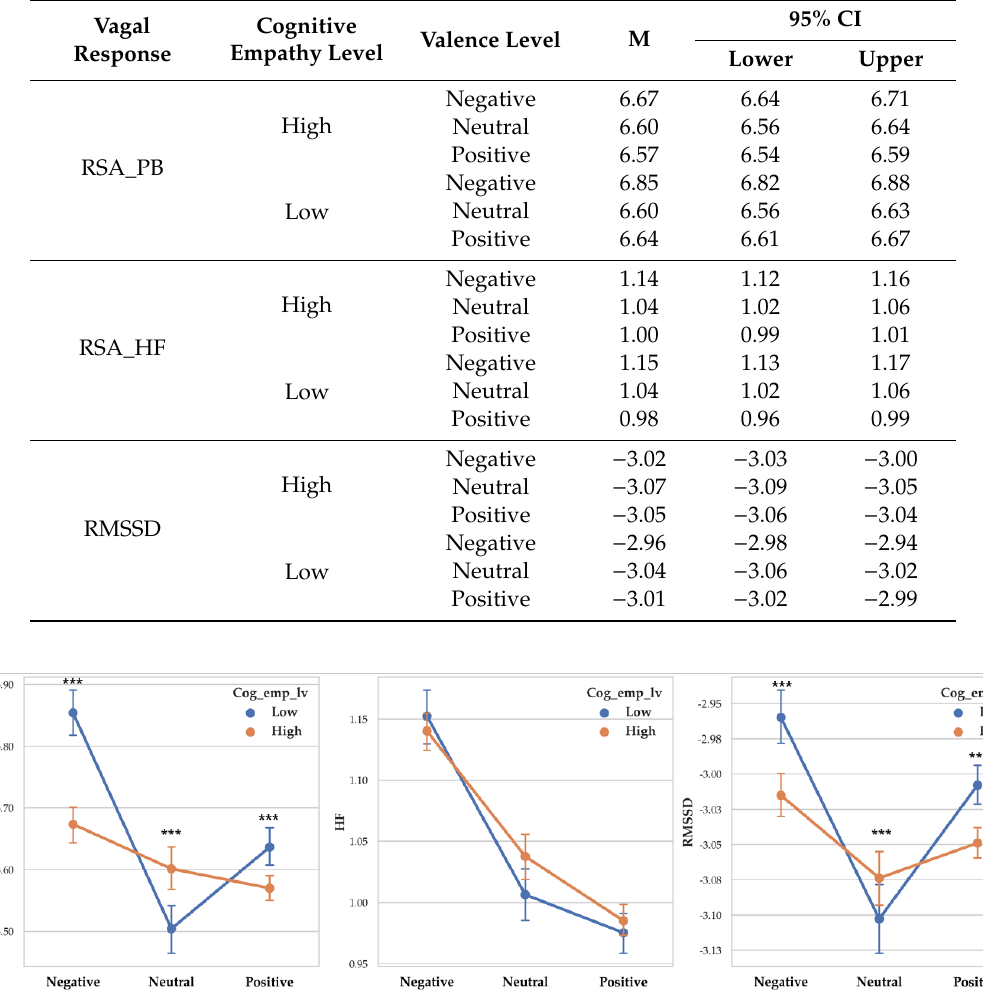
Figure 4. Point graph of vagal responses depending on cognitive empathy level and valence. Cog_emp_lv refers to cognitive empathy level. Point means mean of vagal responses and error bars represent confidence interval. Asterisk means significant vagal responses difference according to cognitive empathy level. (***: p < 0.001.).